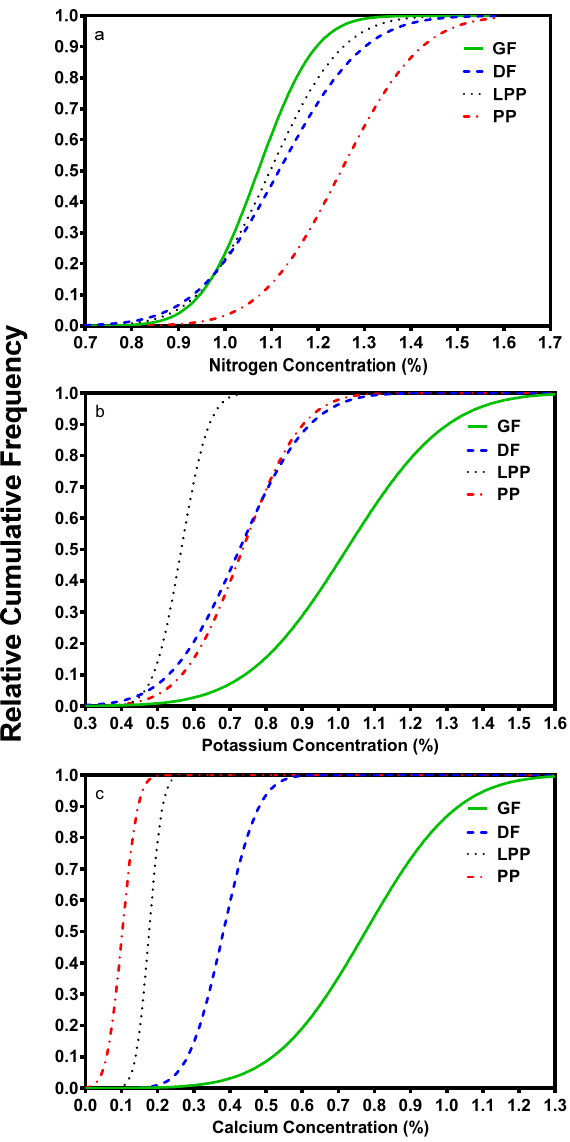
Figure 2. Relative cumulative frequency graphs of foliar N ( a ); K ( b ); and Ca ( c ) concentrations for grand fir (GF), inland Douglas-fir (DF), lodgepole pine (LP), and ponderosa pine (PP). Y -axis shows the proportion of trees sampled that are below the nutrient concentration on the horizontal axis. Foliage was collected from over 160 mixed conifer stands that were randomly selected within categories representing geographic region, habitat type, stand density, and rock type to assure that differences in foliar nutrient characteristics reflect species and not sample site differences